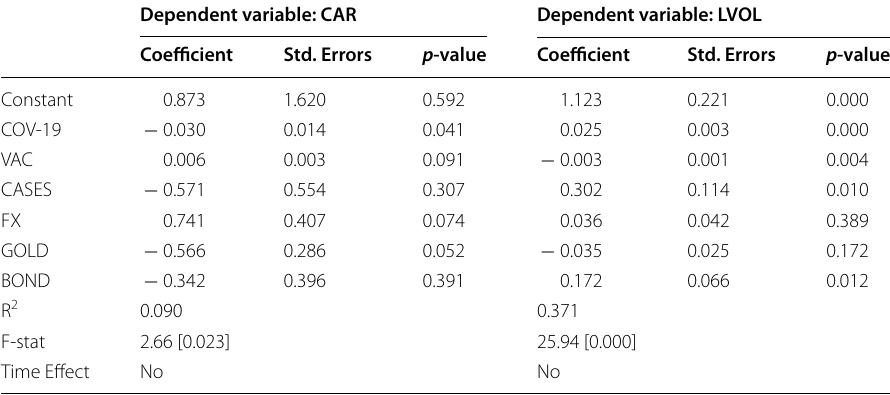
Table 5 Fixed effects panel regression